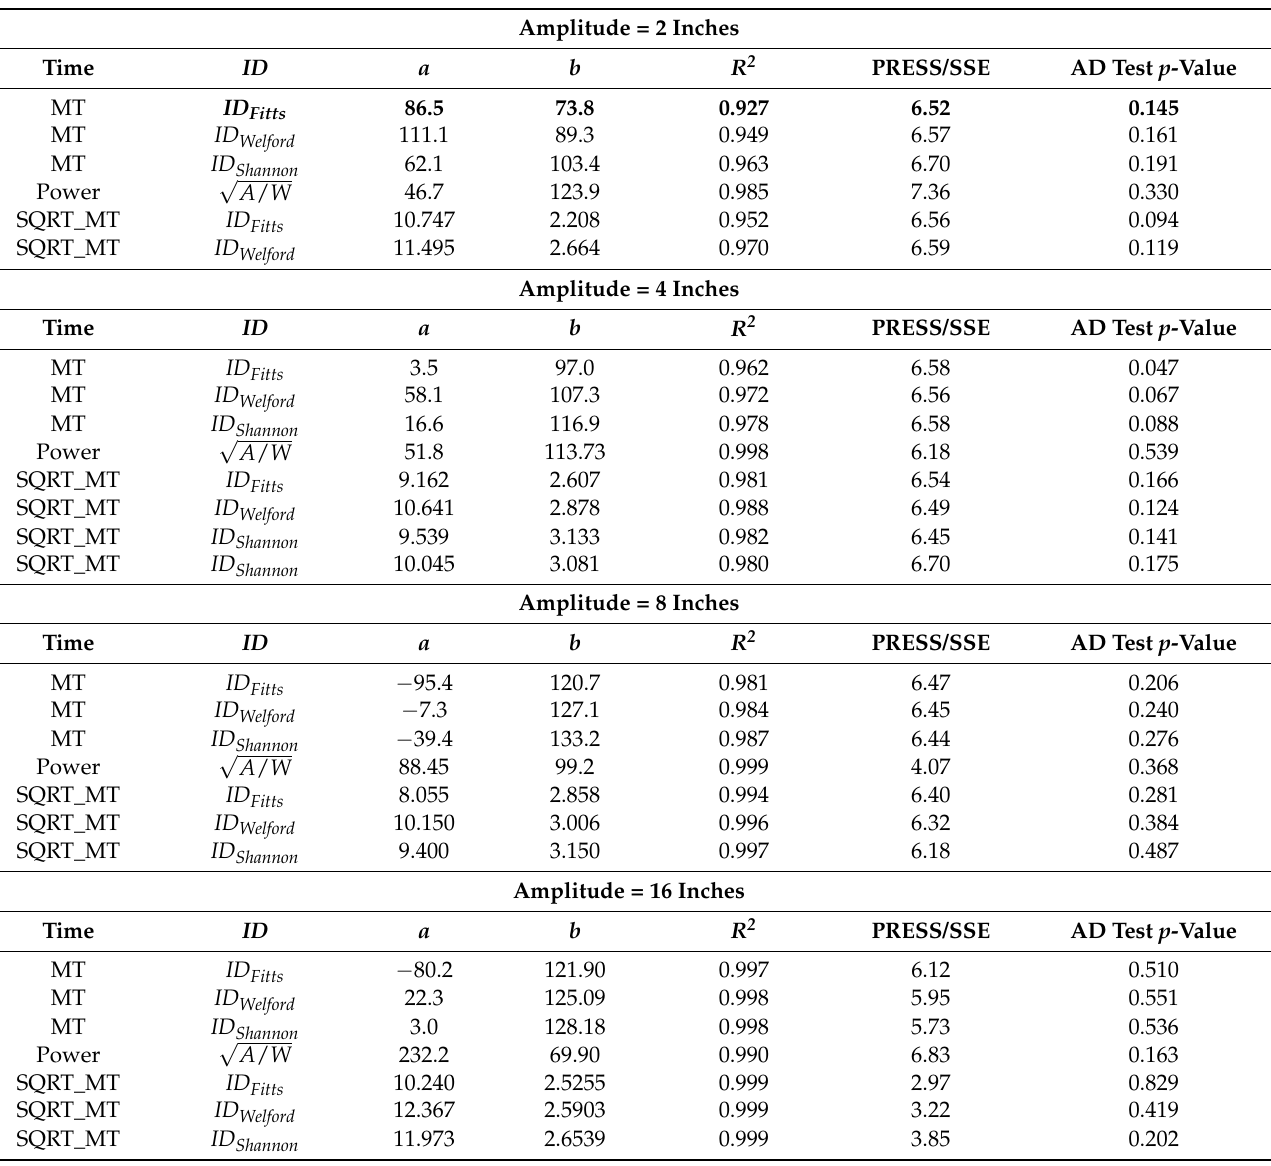
Table 4. Performances of 1 lb stylus tapping at the same amplitude using Fitts’ data [14]. The performances in all statistics but PRESS/SSE were